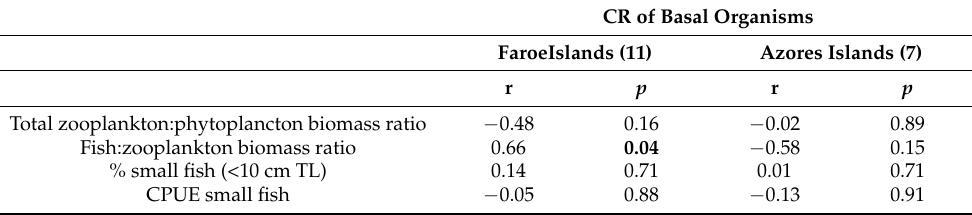
Table 6. Linear correlation analysis between the predator pressure indicators (relative abundance of small fish (<10 cm TL) and CR of basal organisms (log transformed) for the two islands. The number of lakes used in each analysis is given in brackets. For basal organisms, two lakes were excluded in the Azores Islands due to absence of